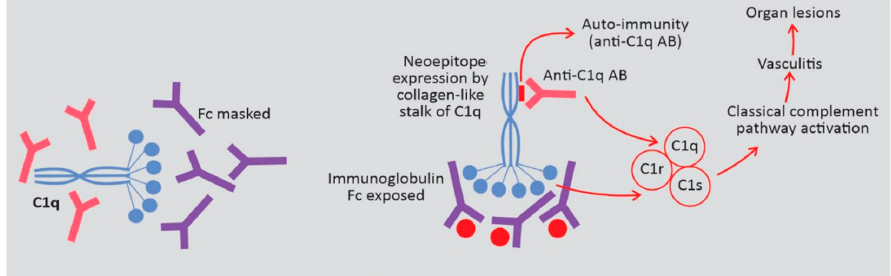
Figure 4. Possible pathogenetic roles of anti-C1q antibody (anti-C1q-AB) in hypocomplementemic urticarial vasculitis syndrome (HUVS).